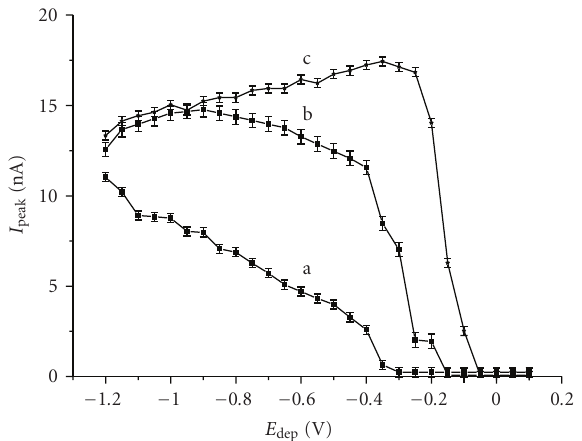
Figure 7: Pseudopolarograms of 10 ppb copper in (a) Original Sample , (b) SoUV Sample, and (c) UV Sample ; DPASV at HMDE, accumulation time 240 s, initial potential − 1.2 V, final potential 0.10V, scan increment 0.05 mV, interval time 0.5 s, scan rate 10mV/s, and 0.1M acetate bu ff er with 0.1M KCl (pH = 4.5).